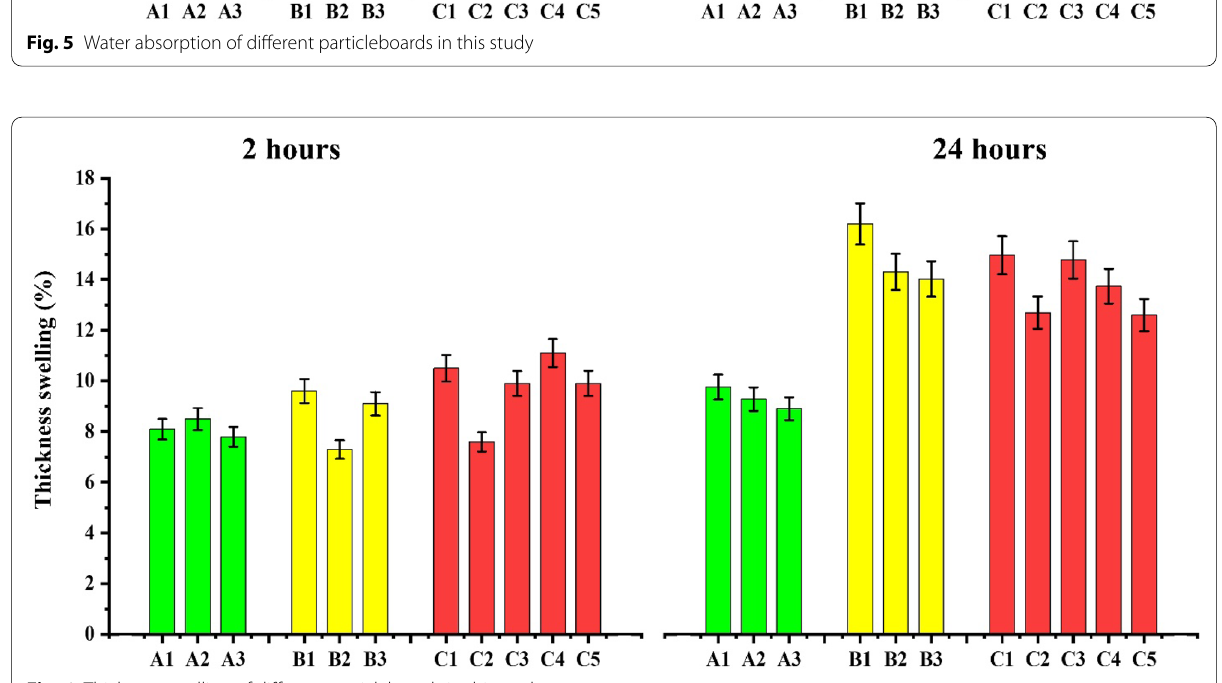
Fig. 6 Thickness swelling of different particleboards in this